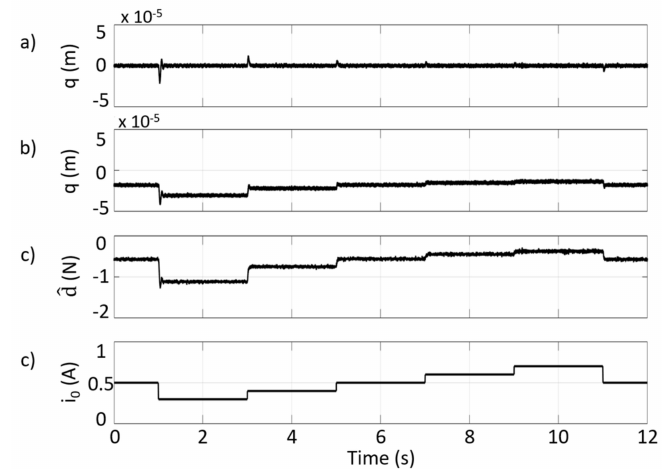
Figure 5. Effects of the plant-model mismatch on OF-MPC ( a ) and MPC ( b ) architectures. ( c ) is the estimation of the force equivalent to the plant-model mismatch (obtained only with OF-MPC architecture) and ( d ) is the variation of bias current provided to the plant.